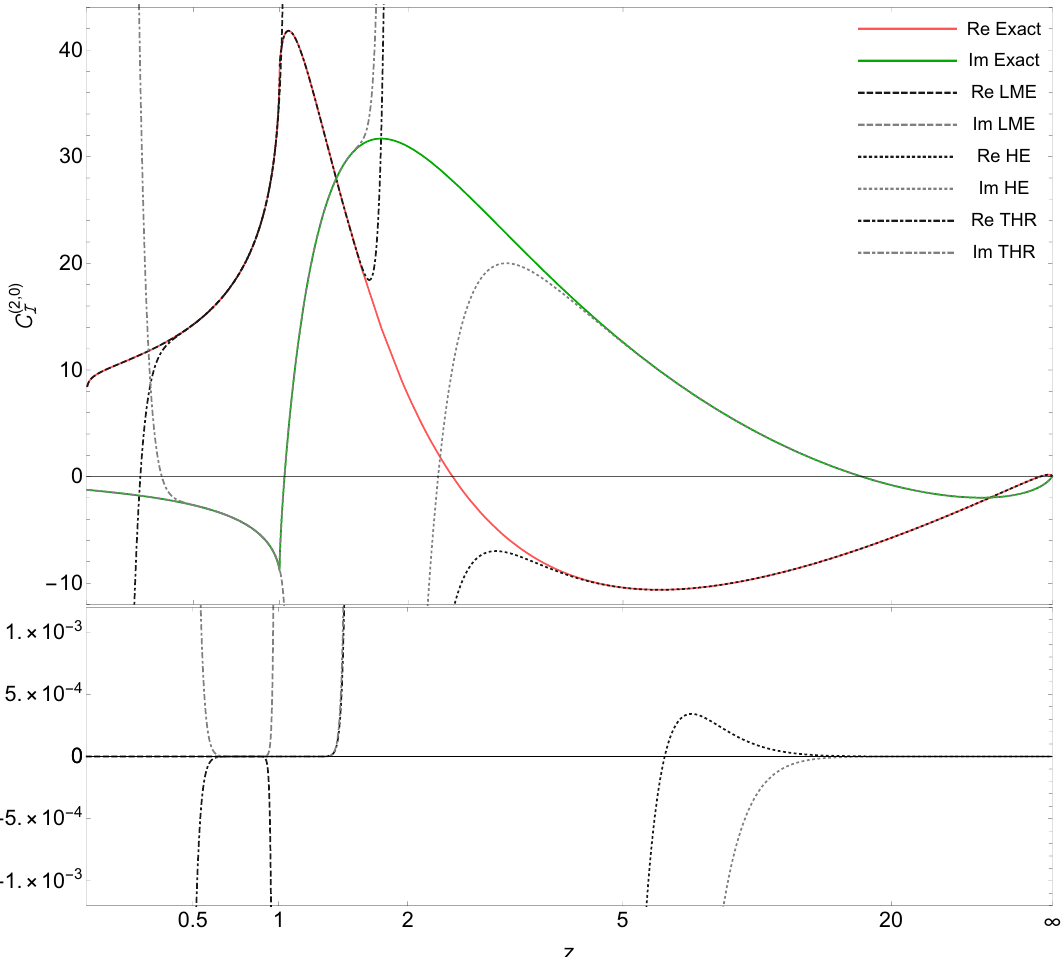
(cid:0) (cid:1) z 100 , threshold expan- (cid:0) (cid:1) 1 =z 8 with at n l = 0, L (cid:22) = 0. The I